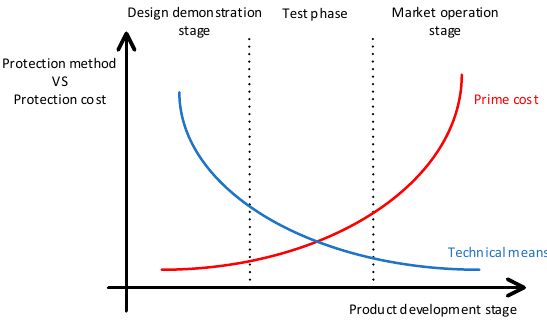
Figure 1. Relationship between the product stage, measures, and cost.